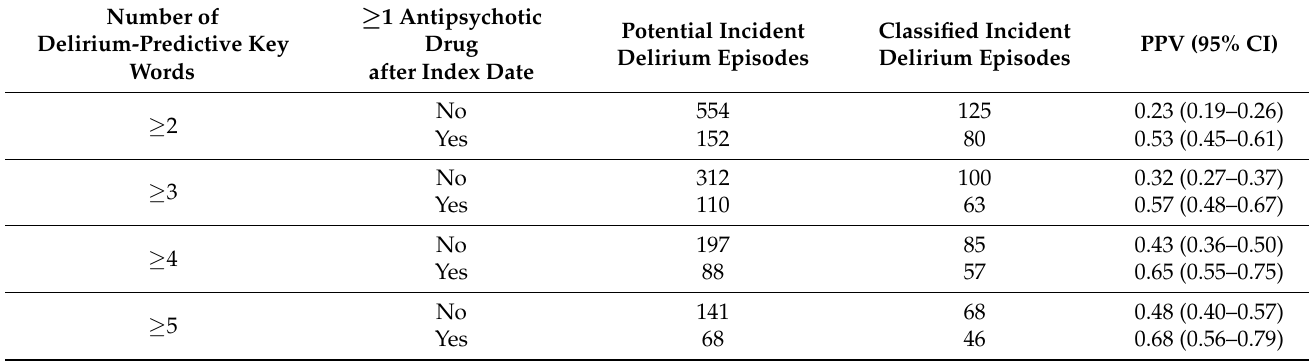
Table 3. Number of potential and confirmed incident delirium episodes with positive predictive values (PPV) and 95% confidence intervals (95% CI) by number of recorded delirium-predictive key words and by administration of at least one antipsychotic drug within 12 h before, at, or at any time after the index